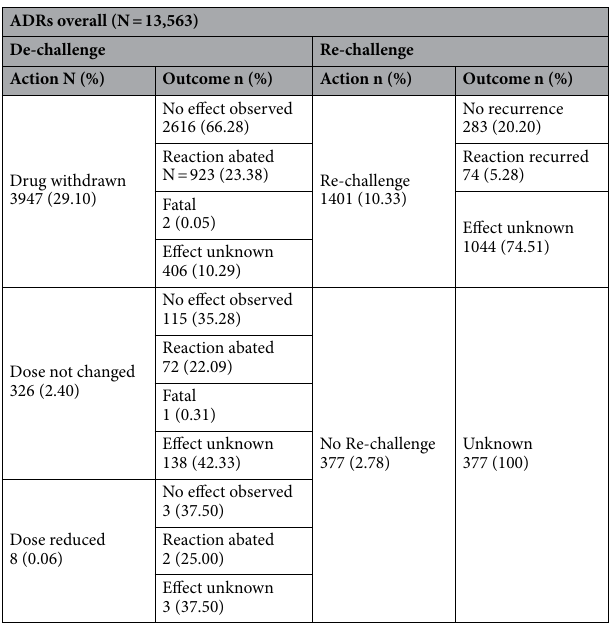
Table 2. ADRs dechallenge and re-challenge actions and outcomes. ADRs adverse drug reactions; N number of ADRs; n number of ADRs in a given